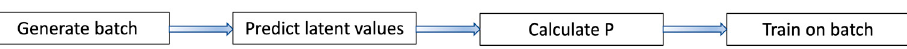
Figure A10. Illustration of the pipeline for generating a training batch. First, examples x are randomly selected. The latent values are then predicted using the first part of the encoder. Thereafter, the probability distribution P is calculated, and x and P are then fed into the full encoder for training.